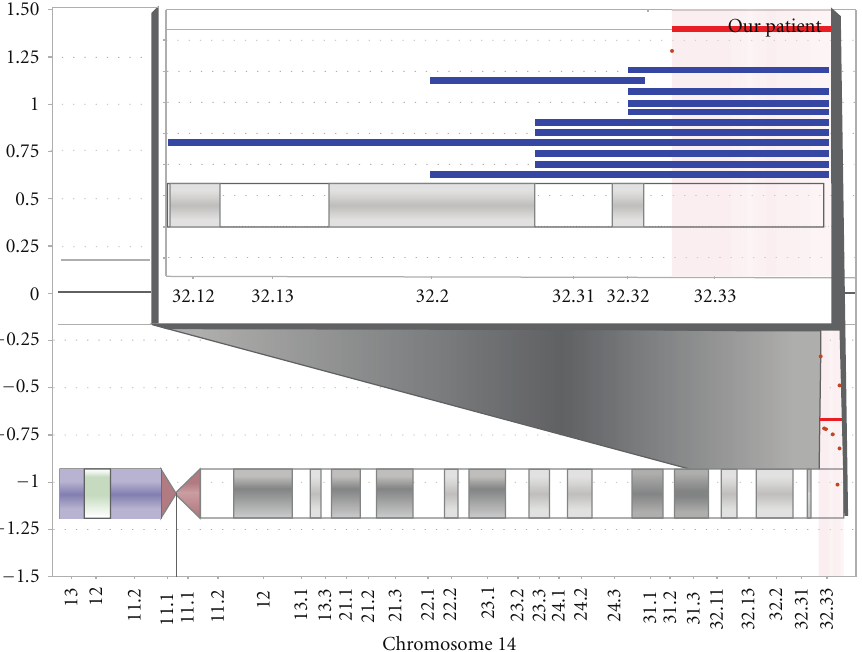
Figure 5: Relative chromosome breakpoints showing the location of the 2.77 Mb deletion at 14q32.33 to 14qter in our patient in relation to the previously described breakpoints for patients with the 14q32.3 deletion syndrome. The blue bars represent the approximate breakpoints and chromosome deletions in the other previously described patients of 14q32 deletion syndrome in [7]. This region includes 48 genes, 16 of which have a known